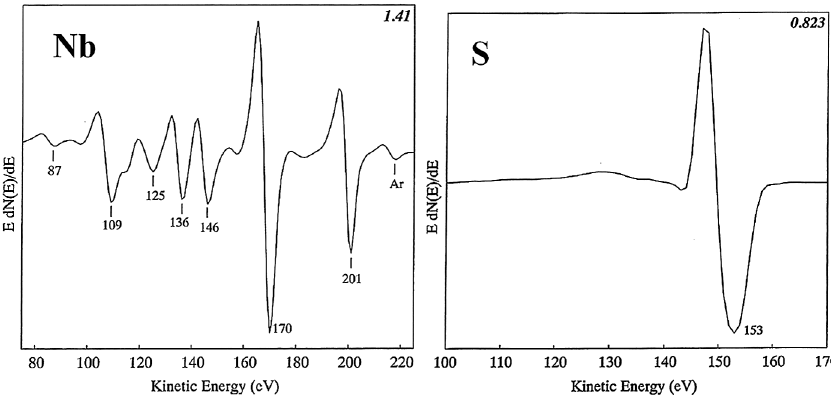
FIG. 2. Fingerprint Auger spectrum of niobium and sulfur [8].